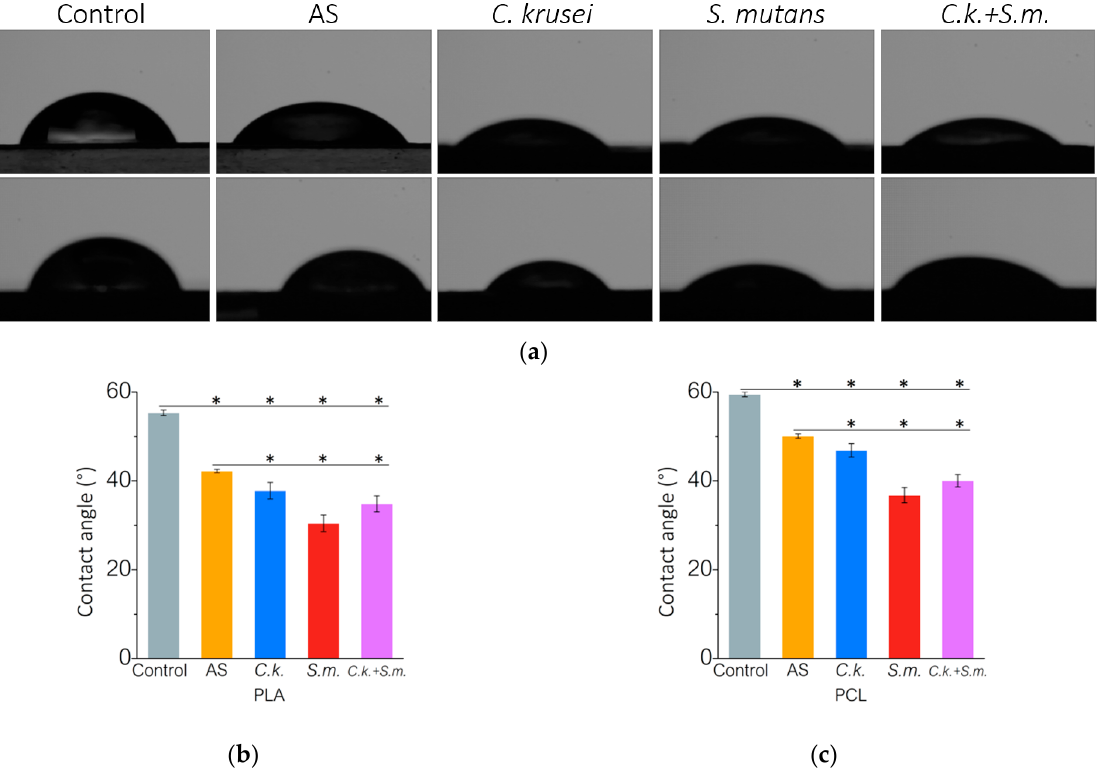
Figure 2. Wettability of PLA and PCL surfaces after incubation in the presence of artificial saliva and microorganisms: ( a ) water droplets on the surface of the tested polymers; ( b ) contact angle at the surface of the PLA; ( c ) contact angle at the surface of the PCL. Results mean ± SD ( n = 3). (*) p < 0.05.